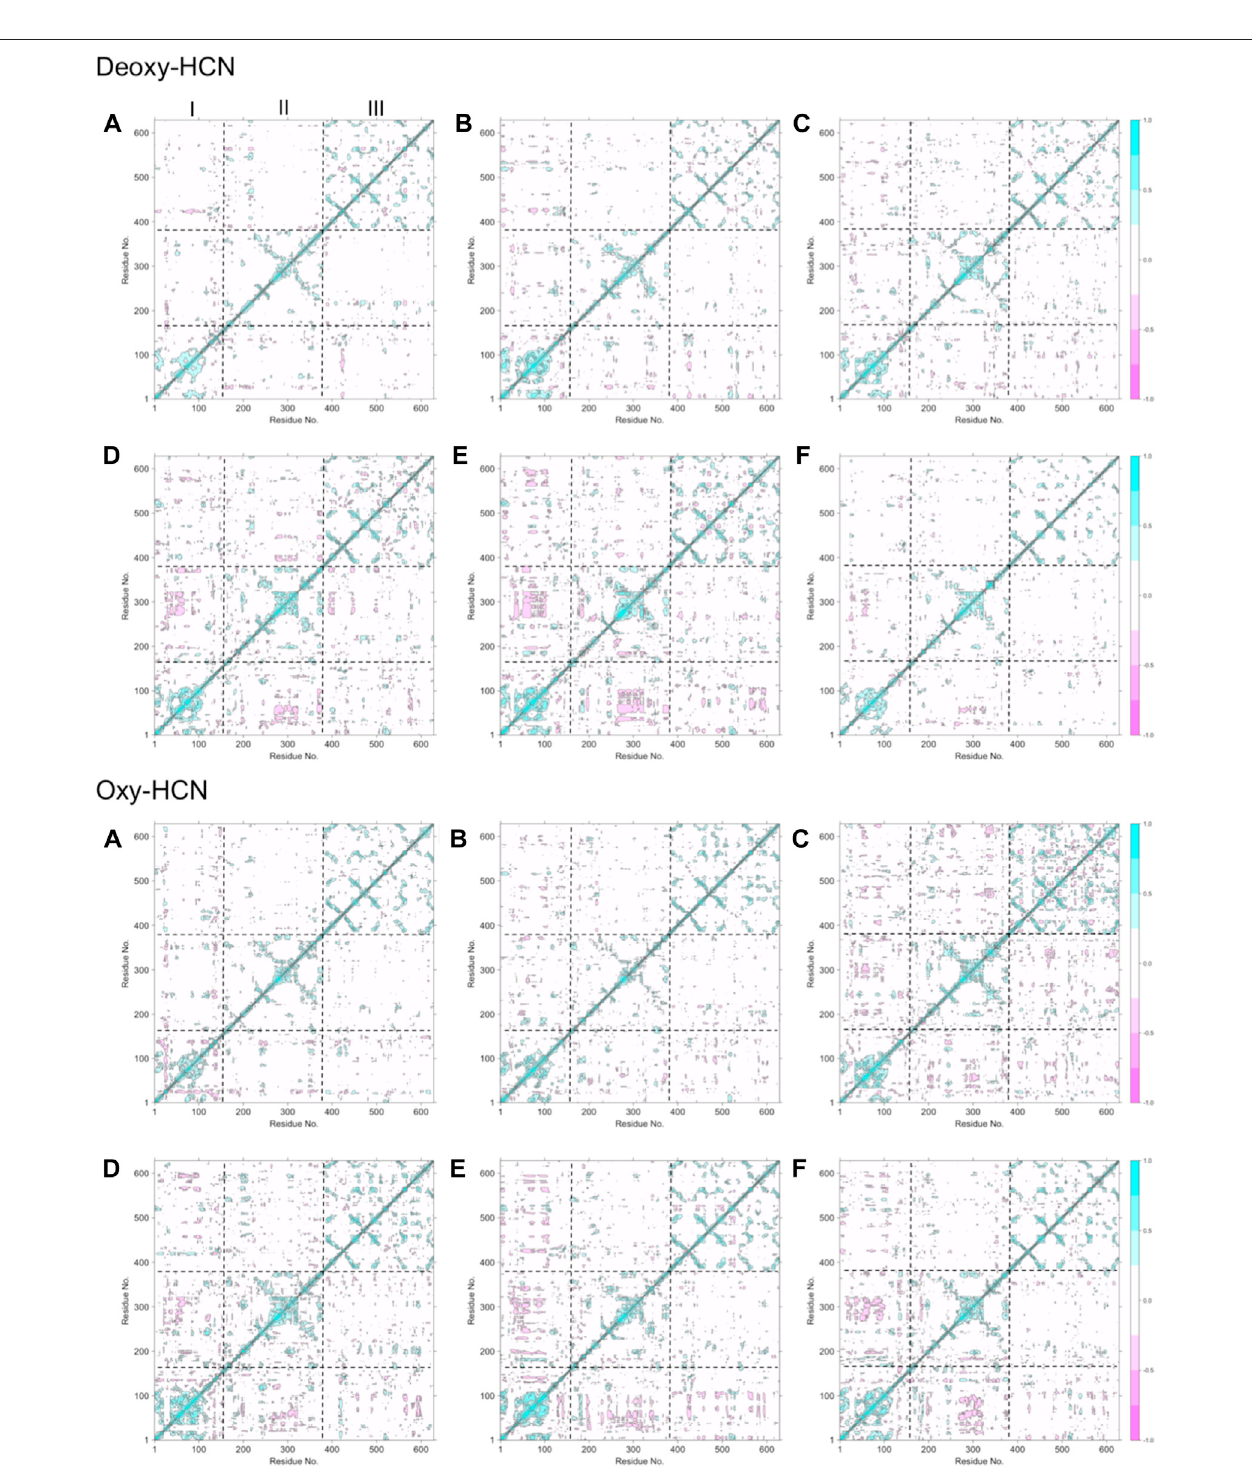
FIGURE 5 | Dynamic cross-correlation matrix (DCCM) maps depicting cross-correlated motion for all six subunits in (A) Deoxy-HCN and (B) Oxy-HCN hexamers. Boundaries of domains I, II, and III are represented by dotted lines. Domains III and I predominantly show positively correlated motions.